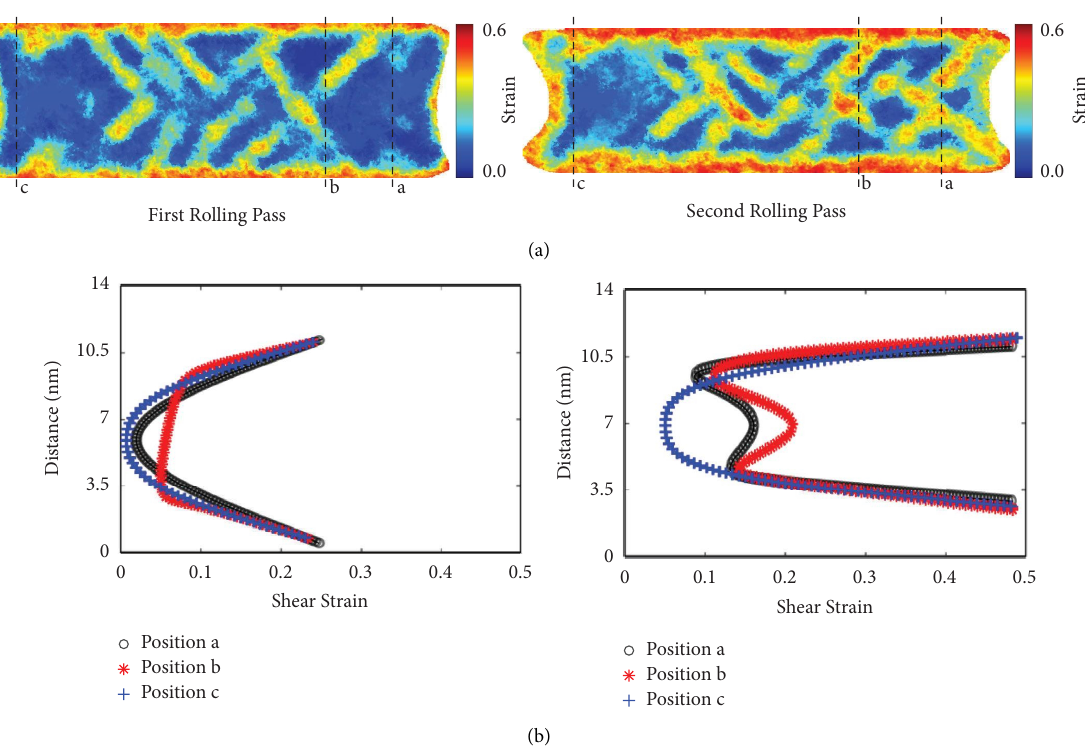
Figure 2: (a) Te snapshots of shear strain at the normal direction (ND) during the cold rolling, (b) the linear distribution of shear strain for selected